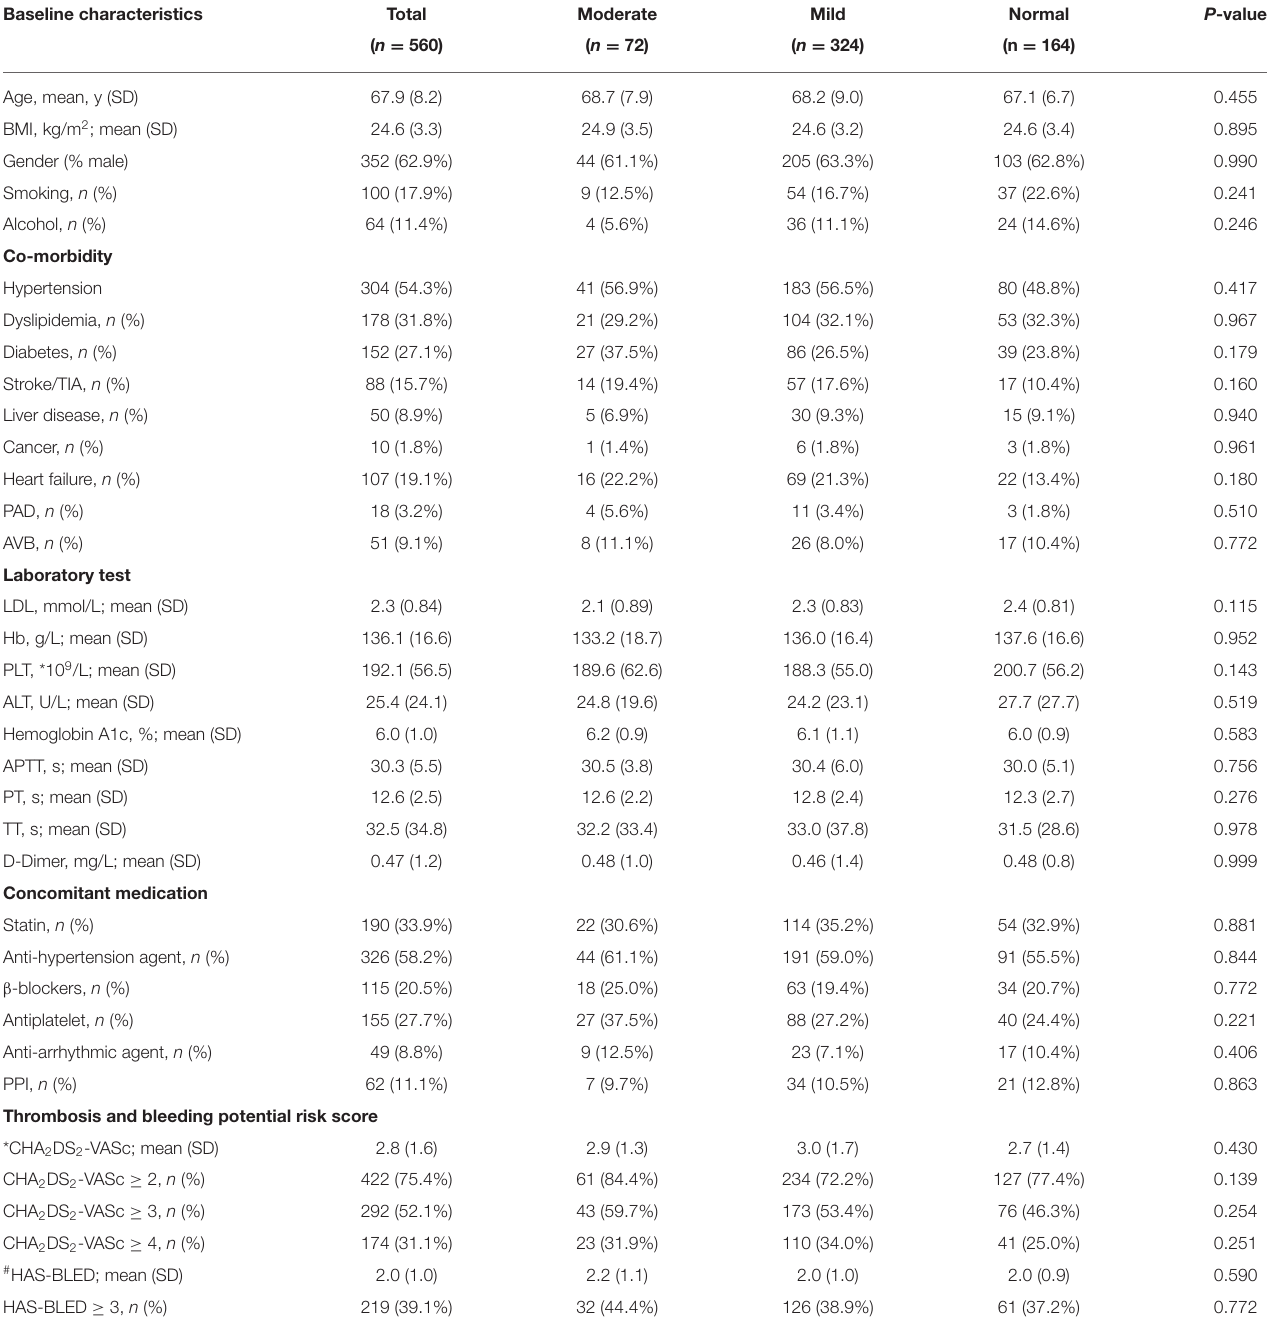
TABLE 1 | Baseline characteristics stratified according to the eGFR category. Baseline